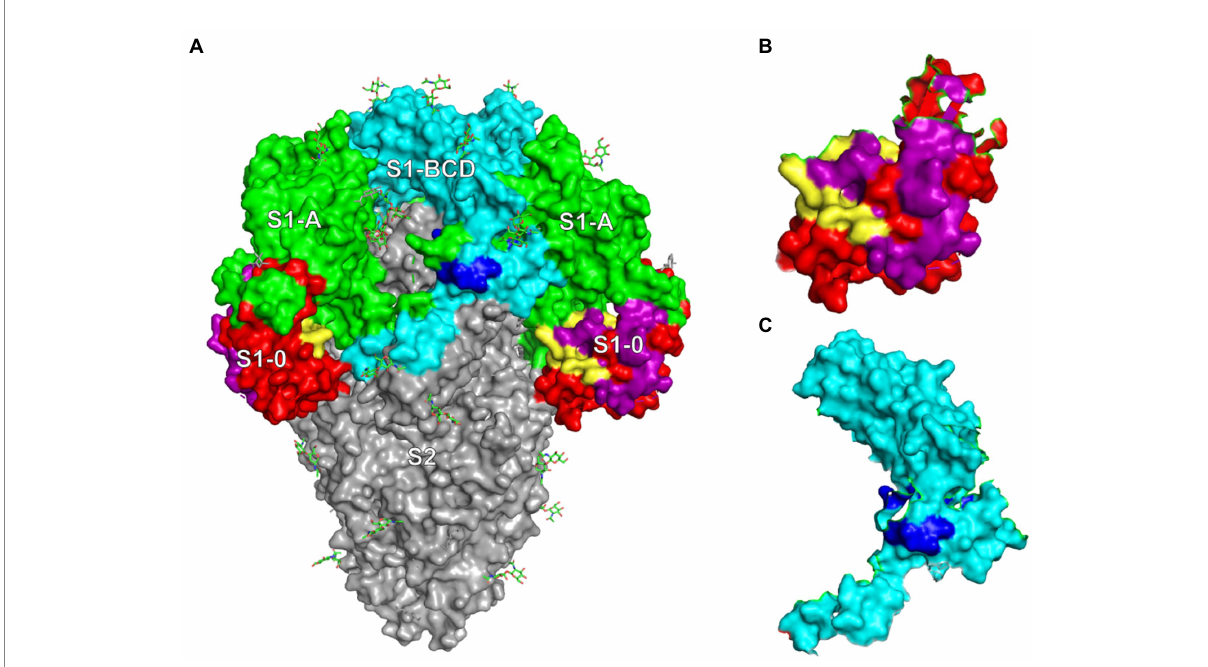
FIGURE 6 (A) PEDV trimeric spike protein (side view) showing locations of S1-0 (red, purple, and yellow), S1-A (green), S1-BCD (cyan and blue), and S2 subunits (gray). (B) Monomeric S1-0 showing the regions matched with phage mimotopes M1-M4 (purple and yellow); the yellow area is the M3S1–0. (C) S1-BCD monomer (cyan) showing the region bound by the mAbG3 (M4S1-BCD in